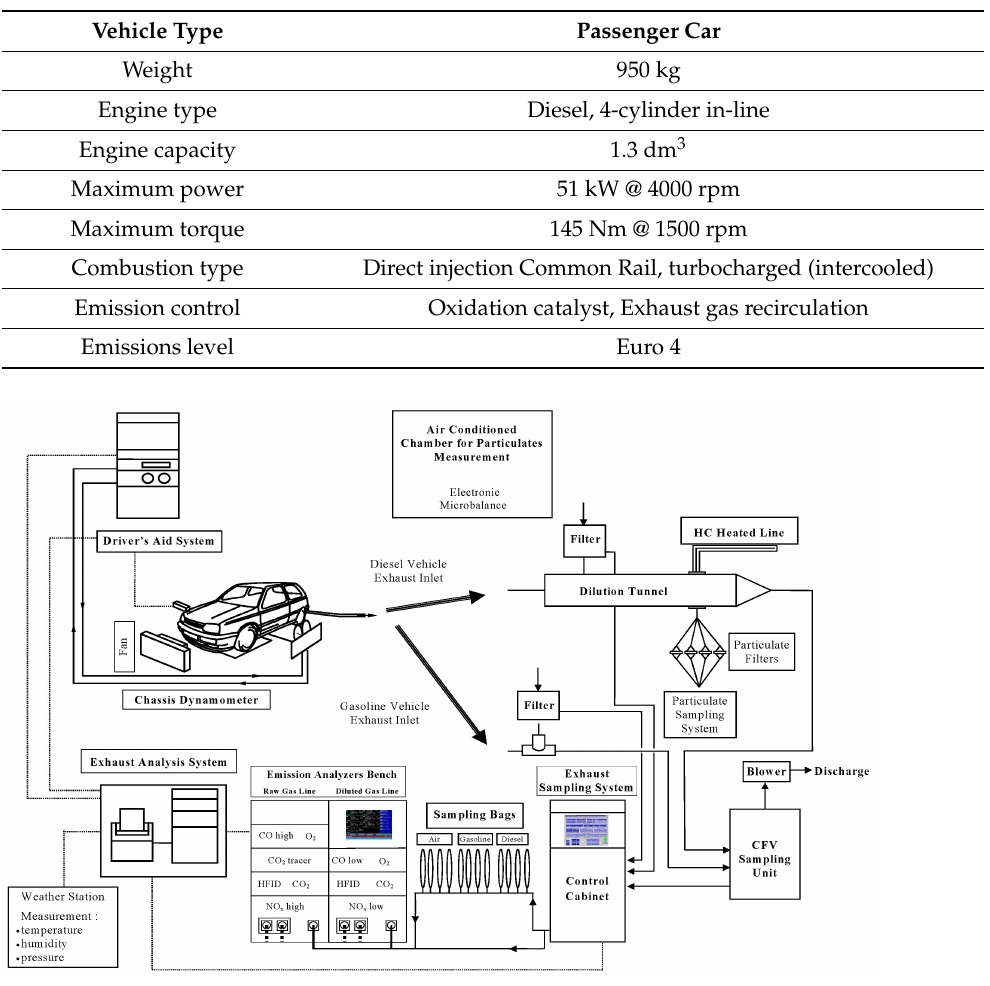
Table 3. Characteristics of the test vehicle.